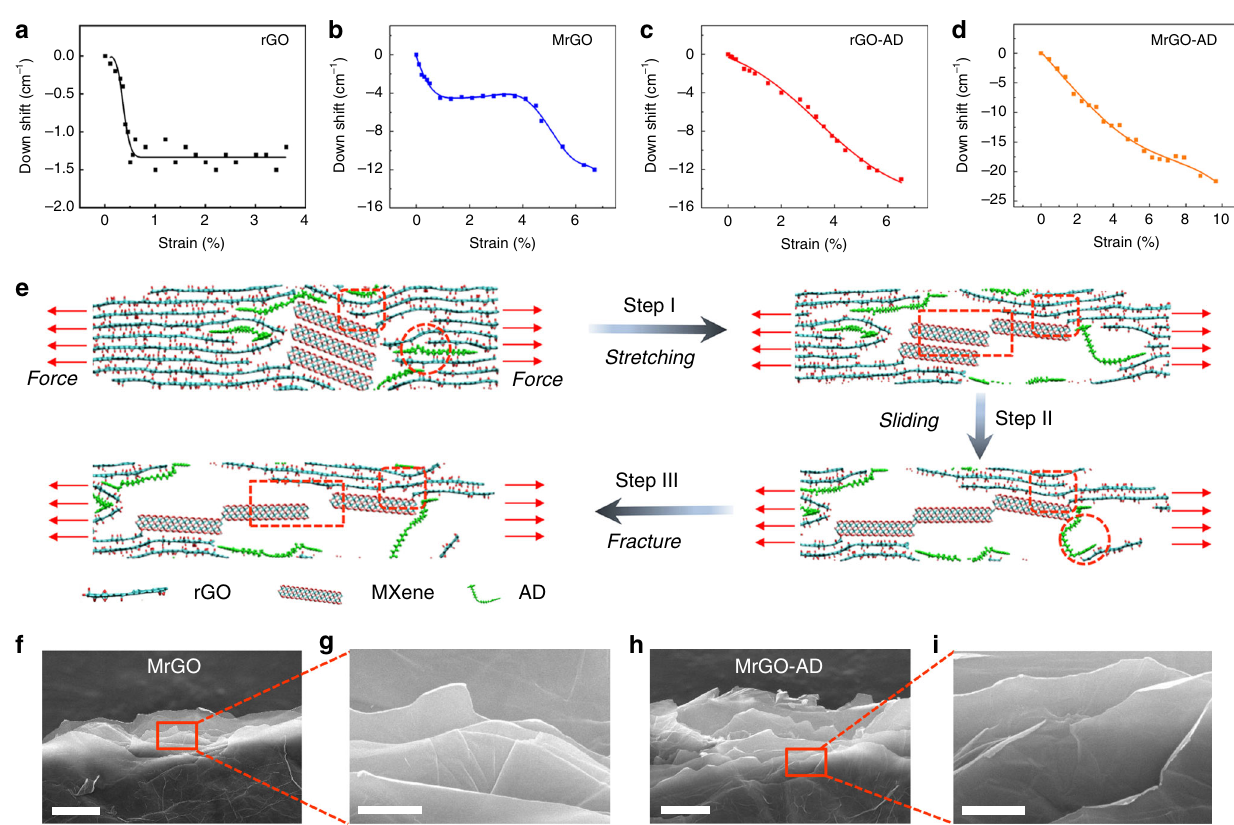
Fig. 3 Toughening mechanisms of graphene sheets. a – d The strain dependence of the downshift in Raman G-band frequency rGO, MrGO, rGO-AD, and MrGO-AD sheets. e The proposed fracture mechanism of the MrGO-AD sheet, according to molecular dynamics simulations. Ti – O-C covalent bonding between MXene nanosheets and rGO platelets (elliptical region), π - π bridging interactions between AD molecules and rGO platelets (circular region), and sliding between MXene nanosheets (rectangle region). f – i Fracture morphology of the side views of MrGO ( f , g ) and MrGO-AD ( h , i ) sheets. Scale bar, 5 μ m ( f , h ) and 1 μ m ( g , i